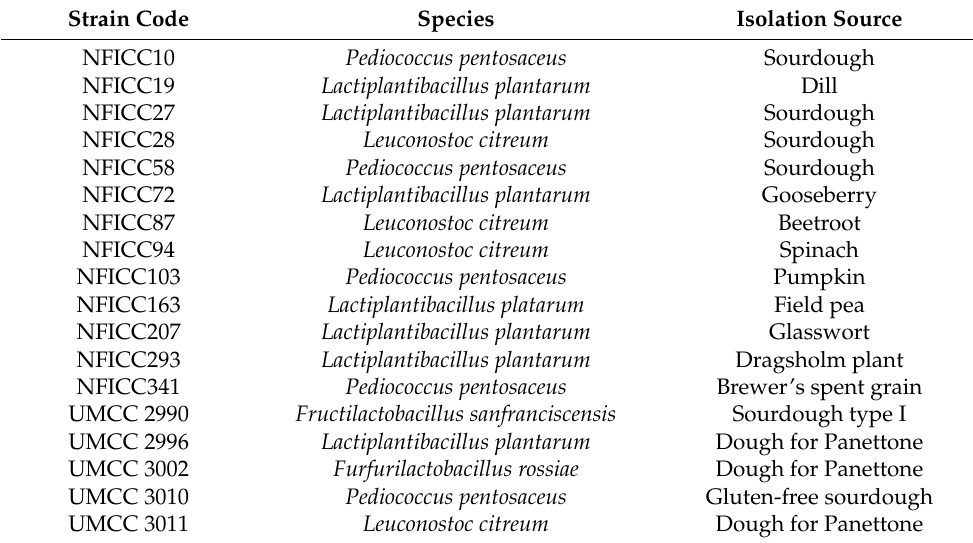
Table 1. Lactic acid bacteria strains tested in the present study. They were provided by the Na- tional Food Institute Culture Collection (NFICC), Technical University of Denmark and by Unimore Microbial Culture Collection (UMCC), University of Modena and Reggio Emilia (Italy).